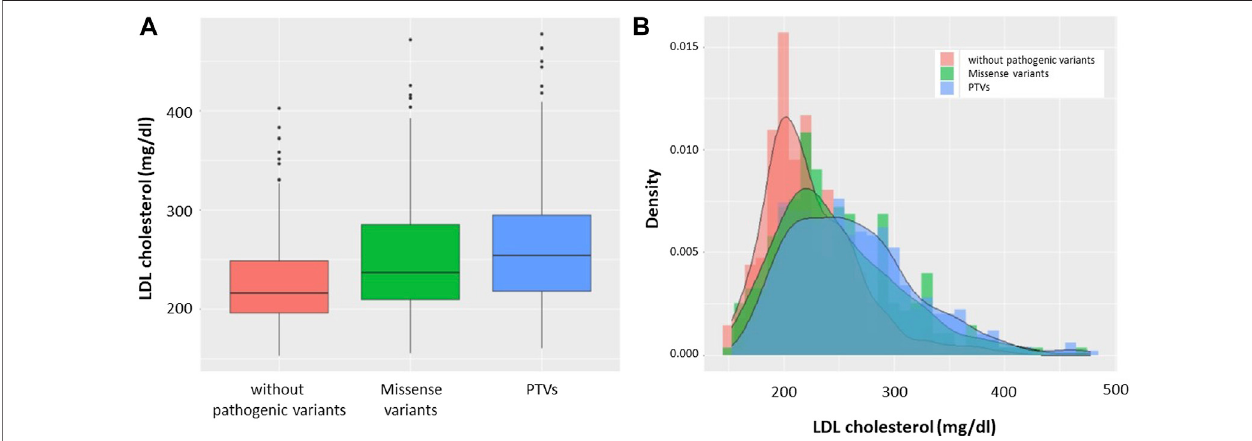
FIGURE 2 | LDL cholesterol levels according to mutation status. (A) Boxplots: Red indicates patients without pathogenic variants. Green indicates patients with missense variants. Blue indicates patients with PTVs. (B) Histograms with density: Red indicates patients without pathogenic variants. Green indicates patients with missense variants. Blue indicates patients with PTVs.